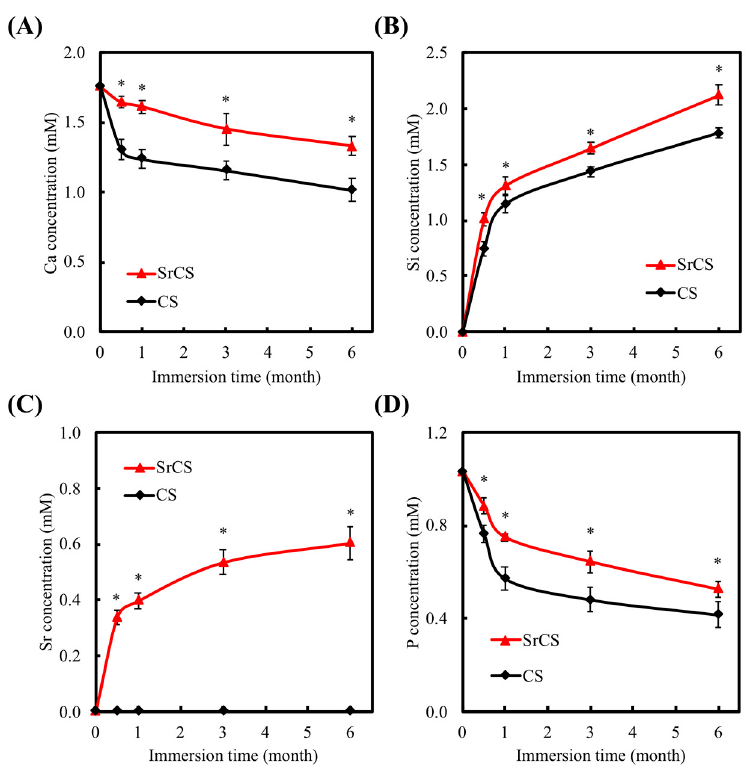
Figure 6. ( A ) Ca, ( B ) Si, ( C ) Sr, and ( D ) P ion concentrations in SBF after immersion for di ff erent durations. Data presented as mean ± SEM, n = 6 for each group. “*” indicates a significant di ff erence ( p < 0.05) when compared to CS sca ff